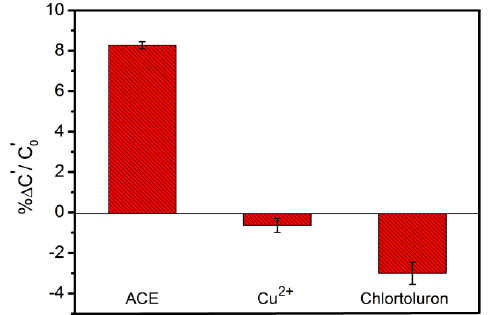
Figure 5. Histograms giving the relative variation of redox capacitance variation after incubation with different interferents.